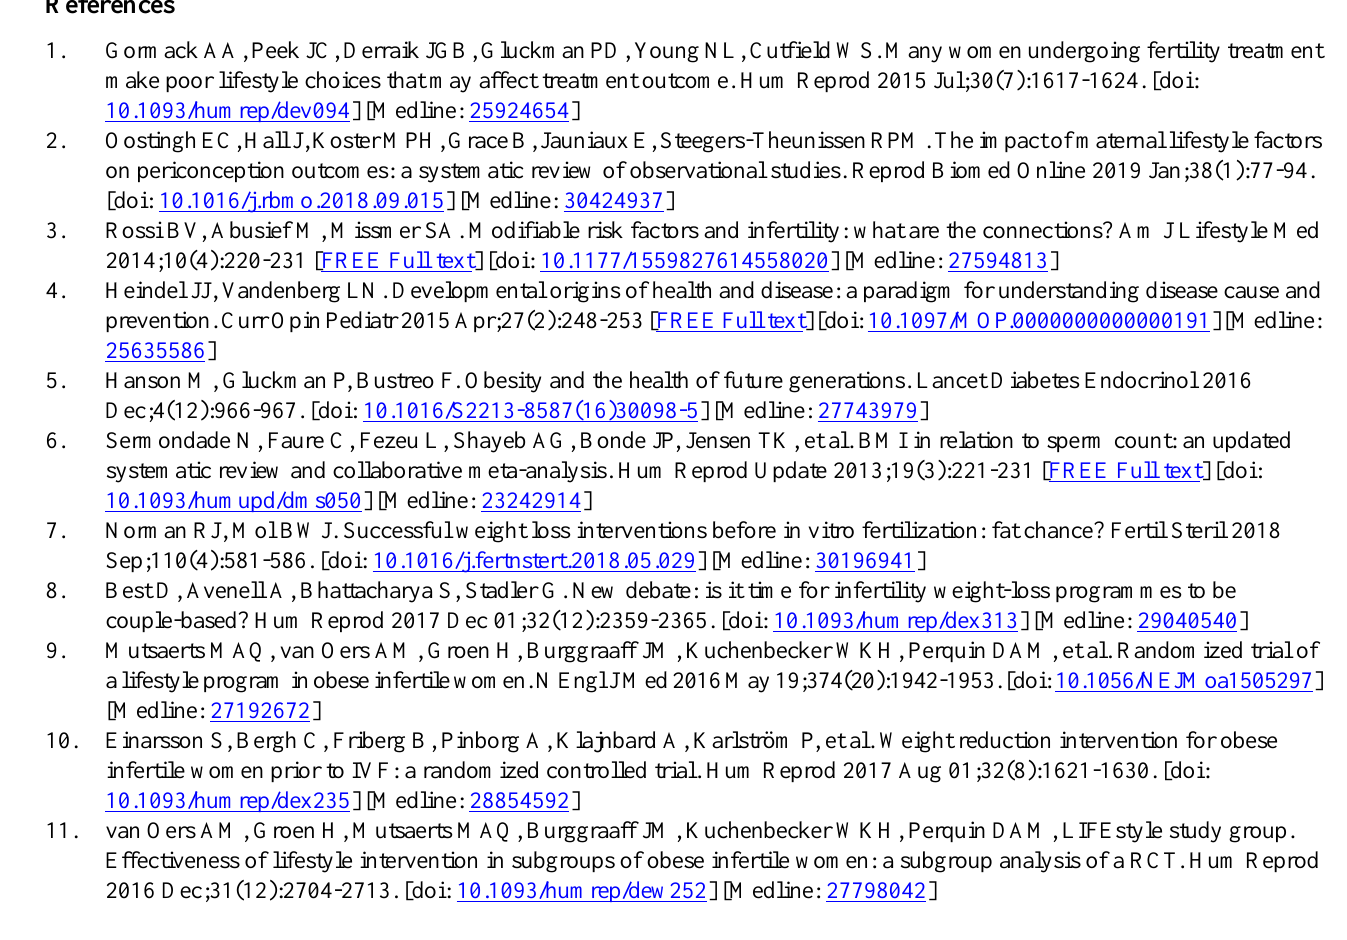
Table S2: Input parameters – assisted reproductive technology costs, assumptions and fertility data from the Netherlands. [DOCX File , 24 KB-Multimedia Appendix